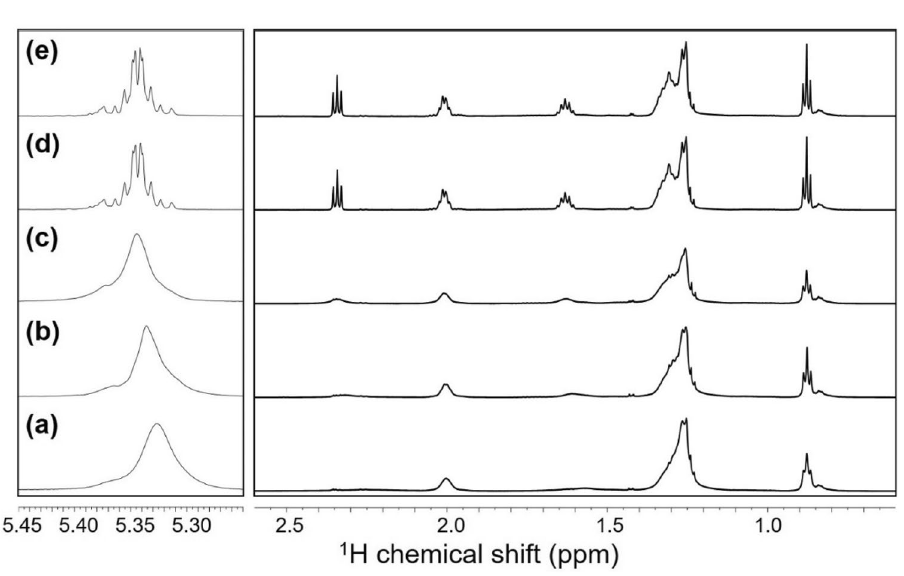
Figure 5. 1 H NMR spectra of InP/ZnS-OA with adding different amounts of H 2 O 2 , ( a ) no H 2 O 2 , ( b ) 5 μL, ( c ) 15 μL, ( d ) 50 μL, and ( e ) 100 μL, and then extracted into the CDCl 3